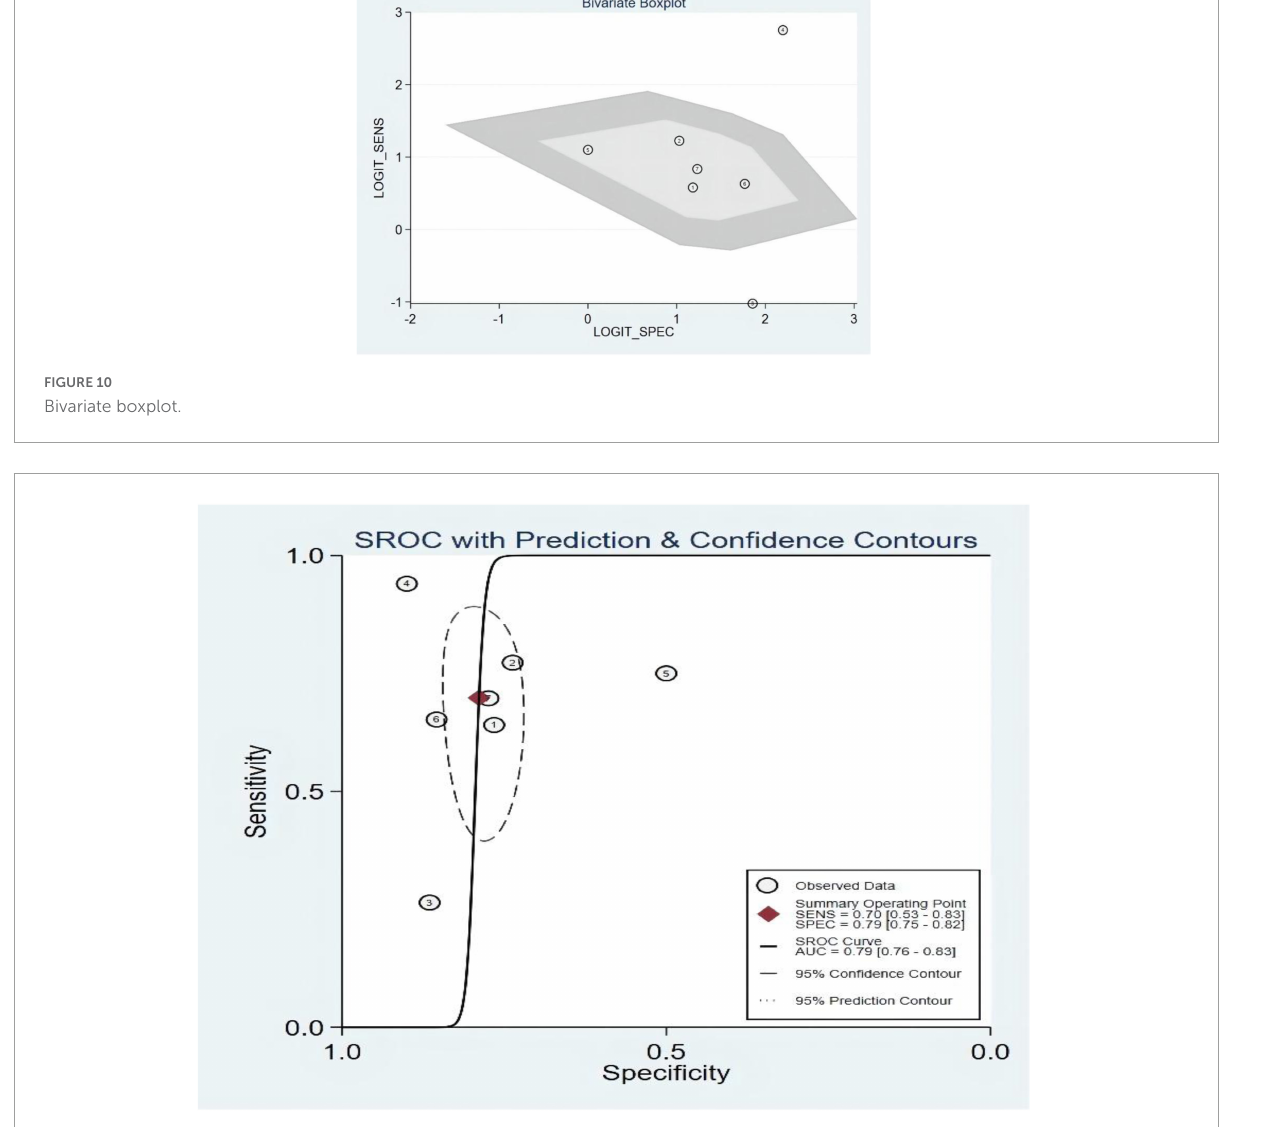
FIGURE11 Summary receiver operating characteristic of left ventricular ejection fraction